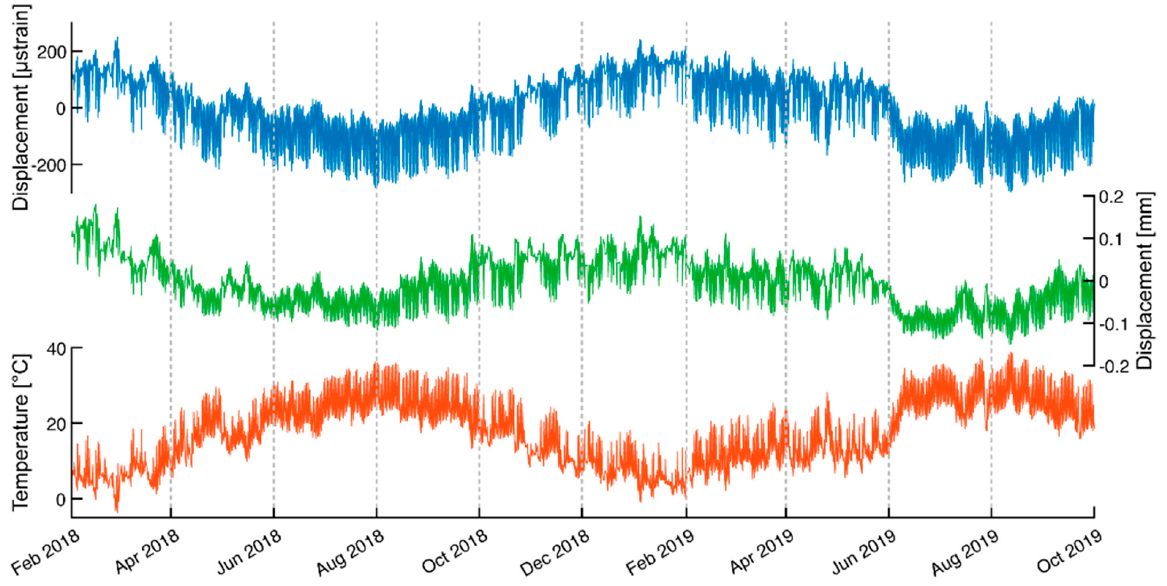
Figure 15. Temporal evolution of displacement (blue and green lines) and rock temperature (orange line) monitoring timeseries recorded by the permanent multiparametric monitoring system at the Acuto field laboratory.